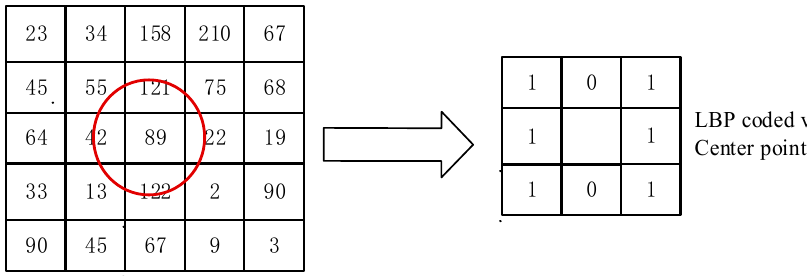
Figure 4. Diagram of the local binary pattern (LBP) descriptor calculation process. HOG [32,33] features have a strong image structure and contour description